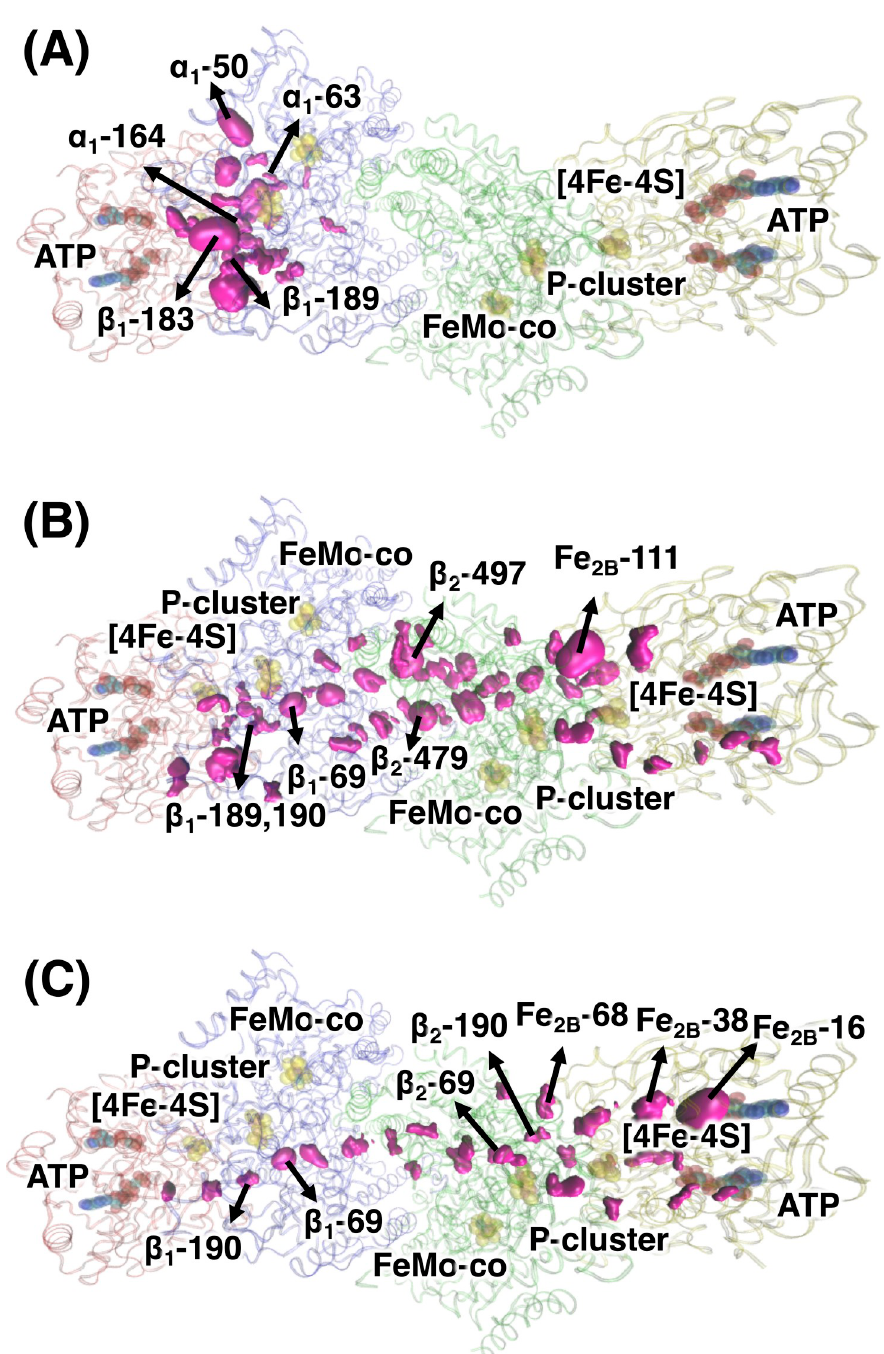
Fig 6. Important residues for mechanical coupling between (A) Fe 1 and α 1 β 1 , (B) Fe 1 and Fe 2 and (C) P-loops in Fe 1 and P-loops in Fe 2 as identified by cost-weighted betweenness centrality, χ . For clarity, only residues with χ > 40% of maximum value are shown as hot pink space-filling structures, whose size is proportional to the magnitude of the corresponding χ value. The ribbon presentation of the ATP-bound nitrogenase complex is colored as follows: Fe 1 , red; Fe 2 , yellow; α 1 β 1 unit of MoFe, blue; α 2 β 2 unit of MoFe, green. ATP, [4Fe-4S] clusters, P-clusters and FeMo-co are shown in spheres. Residues among top 10% of χ or residues in/near the sites of interest are labeled.